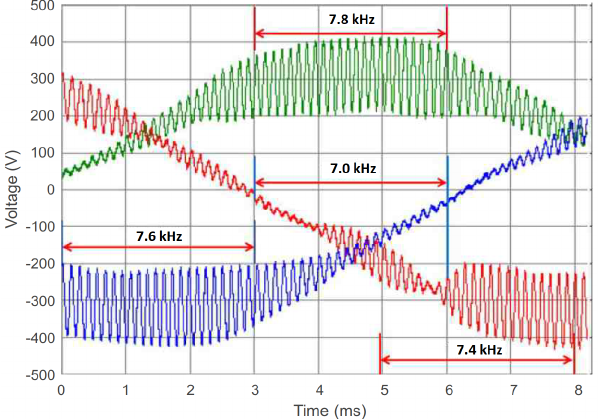
Figure 5. Unstable operation in a data center: distorted phase